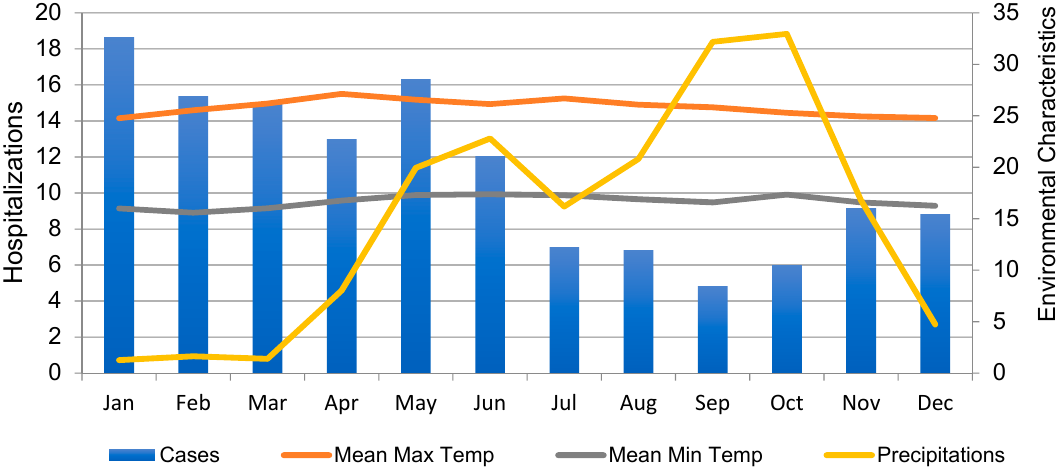
Figure 2. Average monthly counts for rotavirus hospital admissions and average environmental characteristics: rainfall (in cm), a mean maximal and minimal temperature (in ◦ C) in 2010–2015 in the Central Valley of Costa Rica.